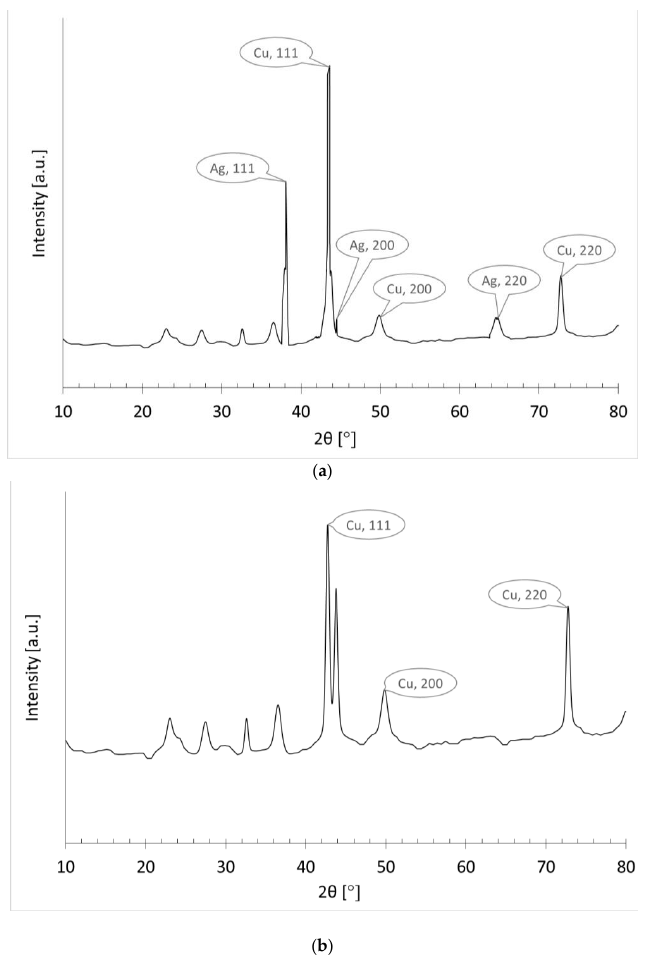
Figure 12. XRD pattern of ( a ) copper electro-plating over the silver particles coated fabric (A9) and ( b ) copper electro-plating over copper particles coated fabric (C9).